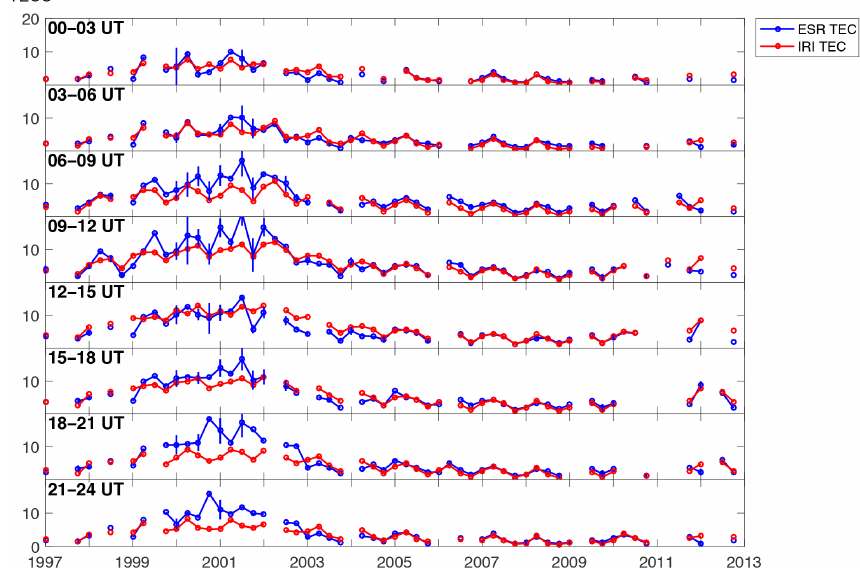
Figure 6. Total electron content from ESR (blue) and IRI model (red) given in TEC units (TECU). Each panel corresponds to a 3h integration bin, and each year contains four seasonal bins (spring, summer, autumn and winter).